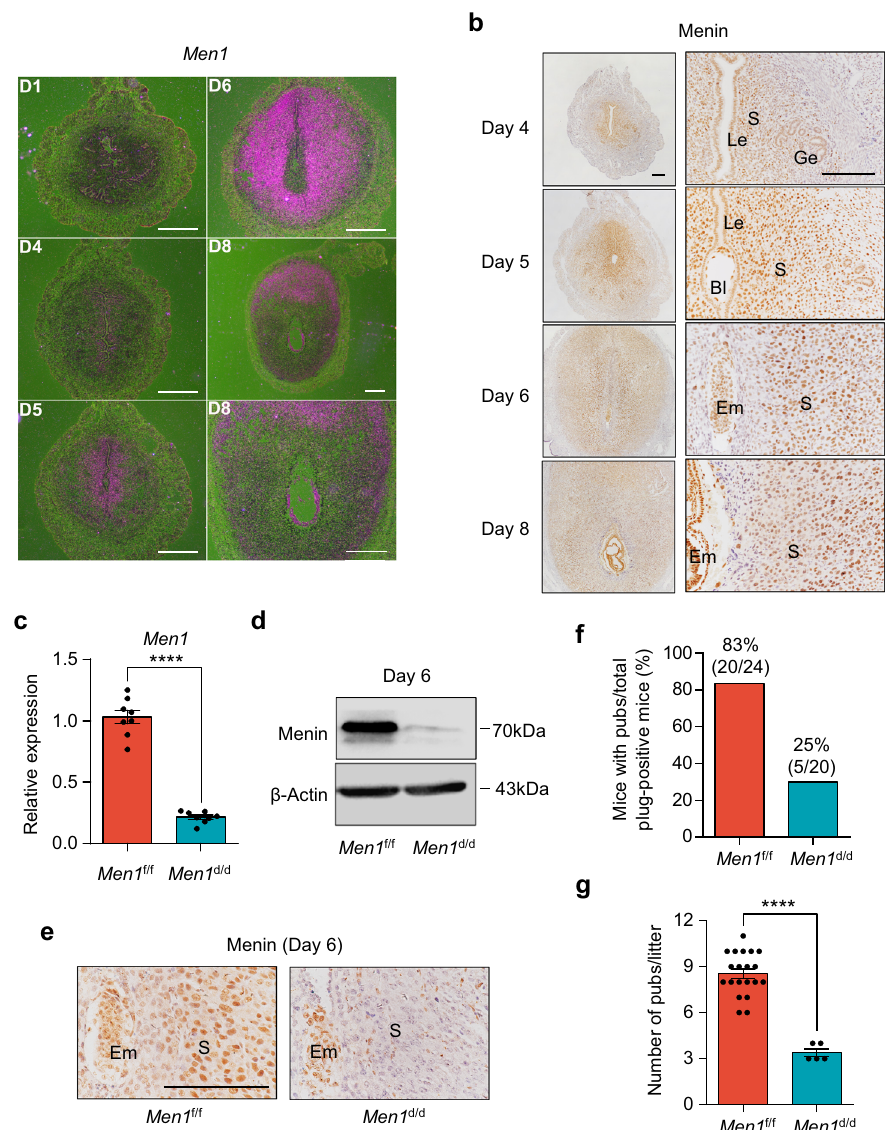
Fig. 1 Uterine-speci fi c deletion of Men1 leads to female subfertility. a In situ hybridization of Men1 in WT uteri on days 1, 4, 5, 6, and 8 of pregnancy. Scale bars: 500 μ m. b Immunohistochemical analysis of Menin in day 4 uteri and days 5, 6, and 8 implantation sites. Le luminal epithelium, Ge glandular epithelium, S stroma, Bl blastocyst, Em embryo. Scale bar: 200 μ m. c Quantitative real-time PCR analysis of Men1 mRNA levels in Men1 f/f and Men1 d/d implantation sites on day 6. The values are normalized to Gapdh and indicated as the mean ± SEM ( n = 8 biologically independent samples). Two-tailed unpaired Student ’ s t -test, **** p = 4.26e-7. d Immunoblotting analysis of Menin protein in Men1 f/f and Men1 d/d implantation sites on day 6. Β -Actin was used as a loading control. e Immunohistochemical analysis of Menin in Men1 f/f and Men1 d/d implantation sites on day 6. S stroma, Em embryo. Scale bar: 200 μ m. f Pregnancy rates in Men1 f/f and Men1 d/d female mice. The number within brackets indicates females with pups over total number of plug-positive females. g Average litter sizes in Men1 f/f ( n = 20 animals) and Men1 d/d ( n = 5 animals) mice. Data represent the mean ± SEM. Two-tailed unpaired Student ’ s t -test, **** p =